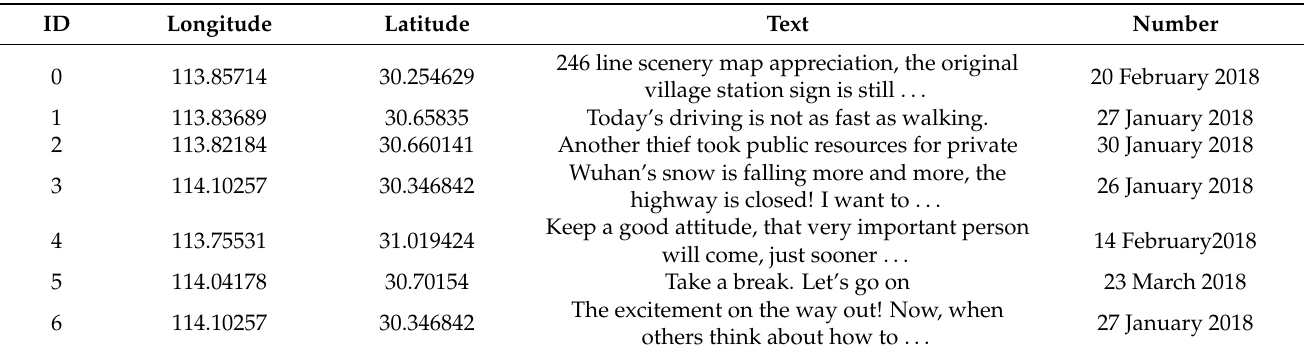
Table 1. Part of the original data